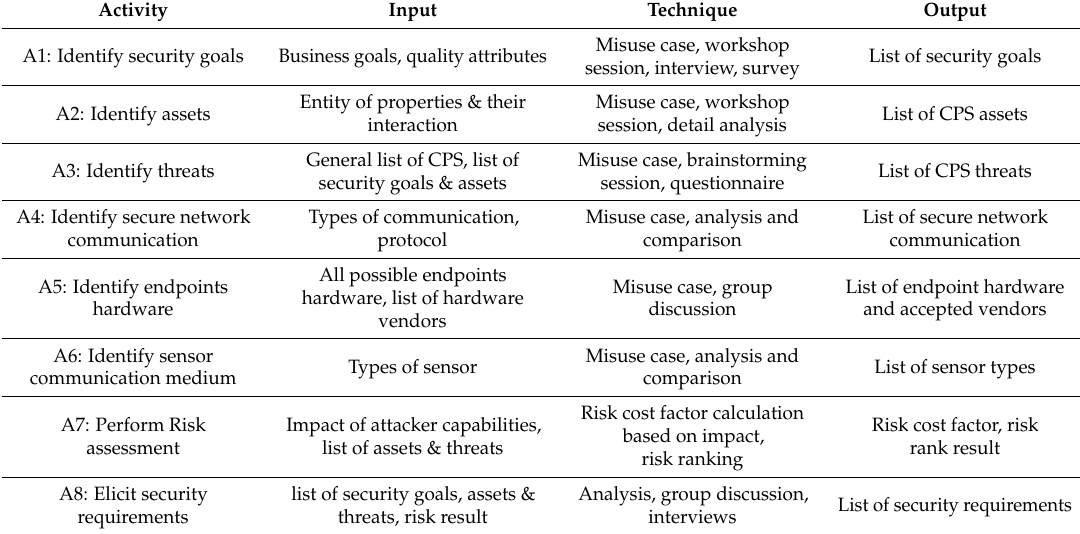
Table 1. Framework Workflow